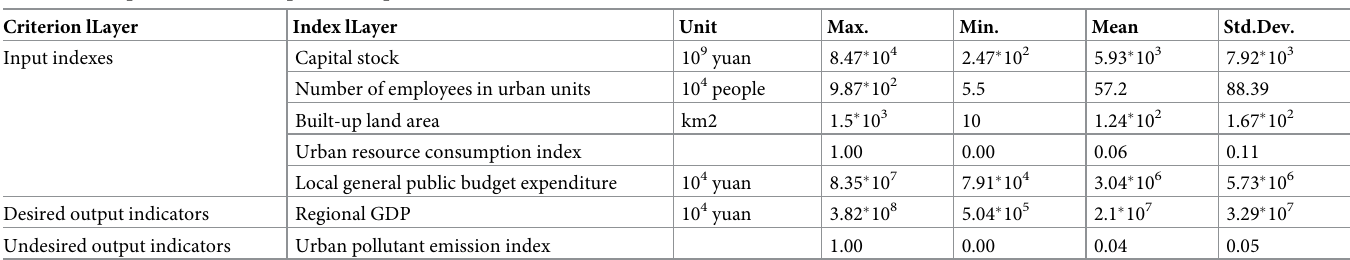
Table 5. Descriptive statistics of input and output indexes.